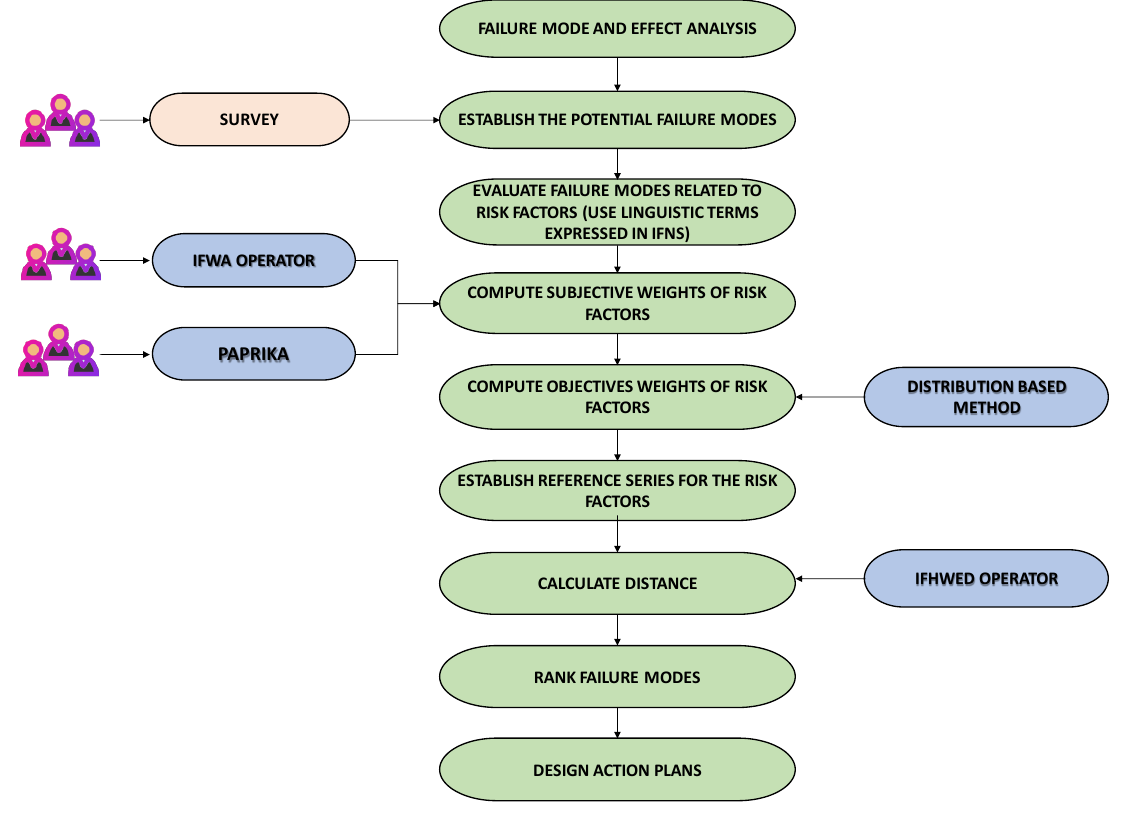
Figure 1. Flowchart of the study.